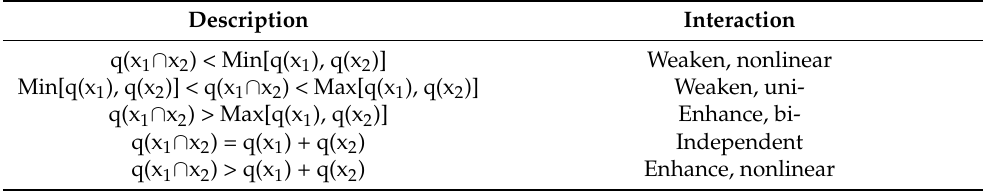
Table 2. Types of interactions.